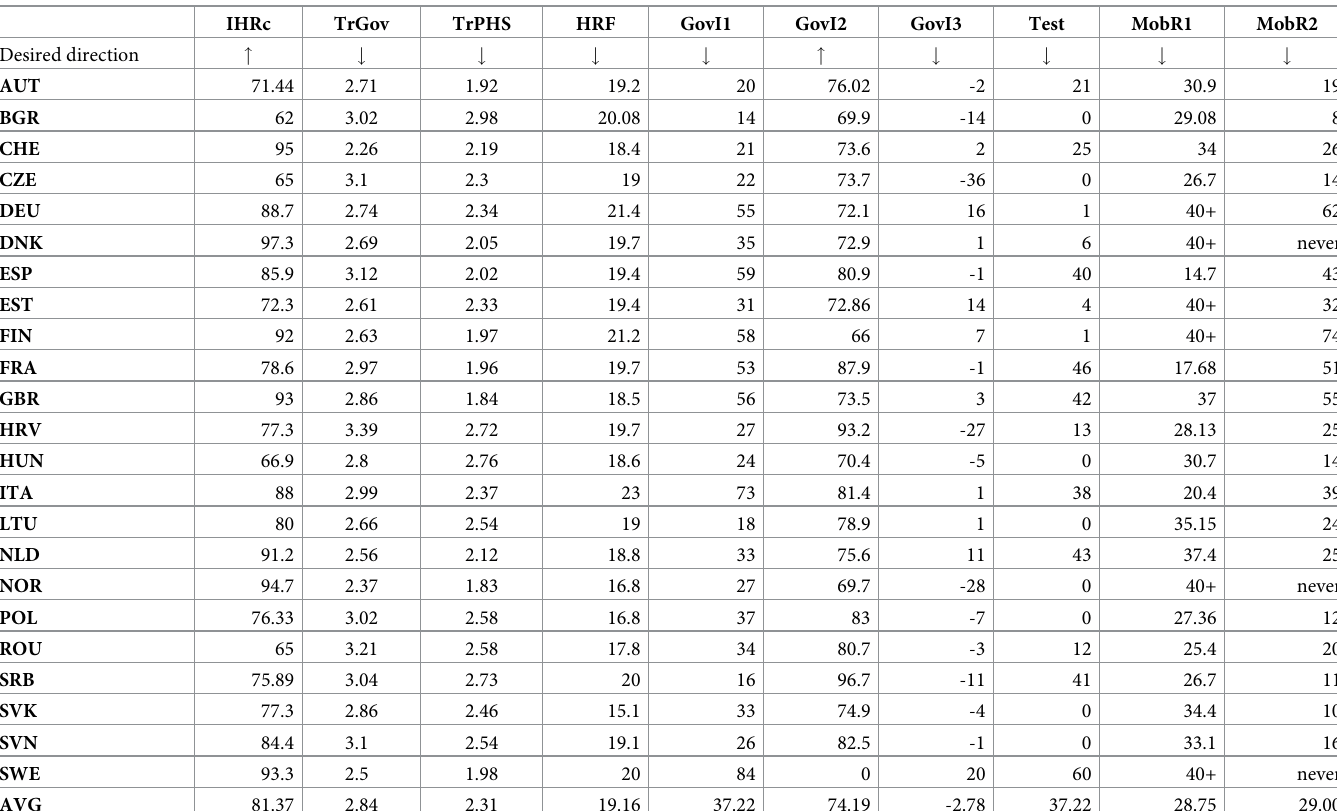
Table 3. Data for 23 European